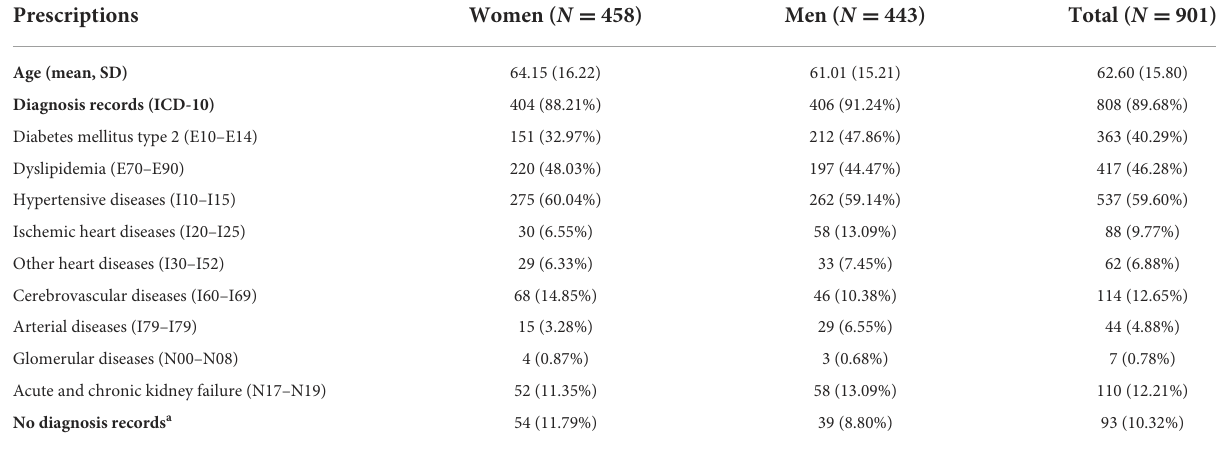
TABLE 2 Characteristics of the